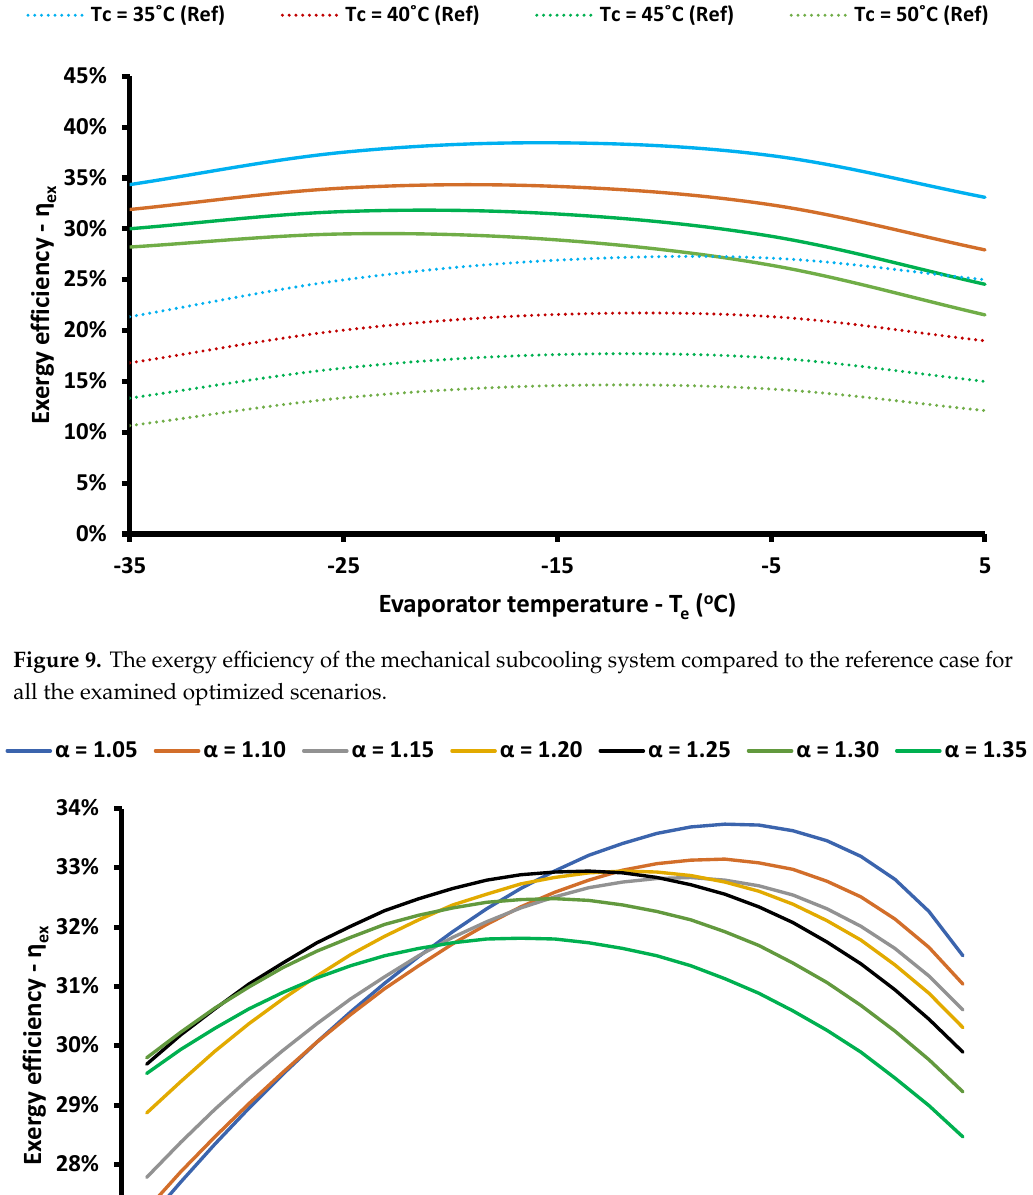
Figure 8. The COP of the mechanical subcooling system compared to the reference case for all the examined optimized scenarios.